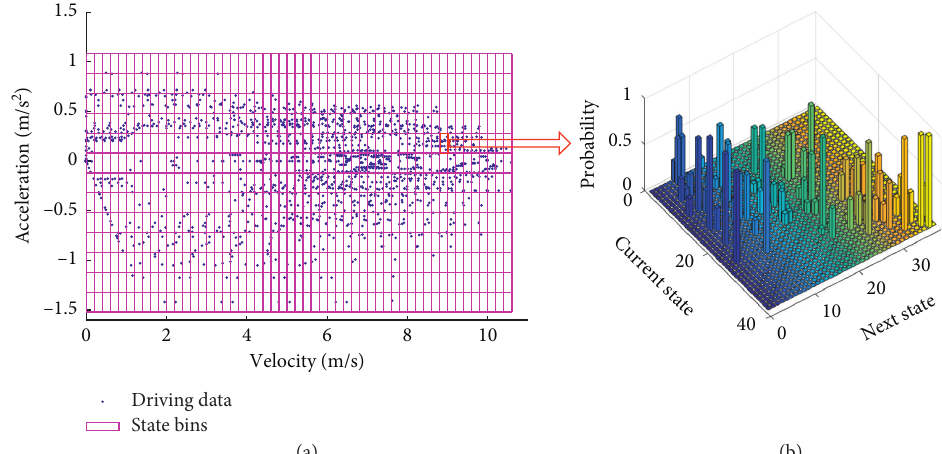
Figure 5: Markov chain model for a kinematic segment dataset. (a) State bins of the driving data and (b) TPM of a certain state.